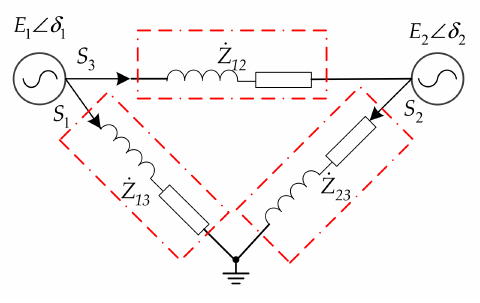
Figure A1. Schematic diagram of conversion equivalent parallel